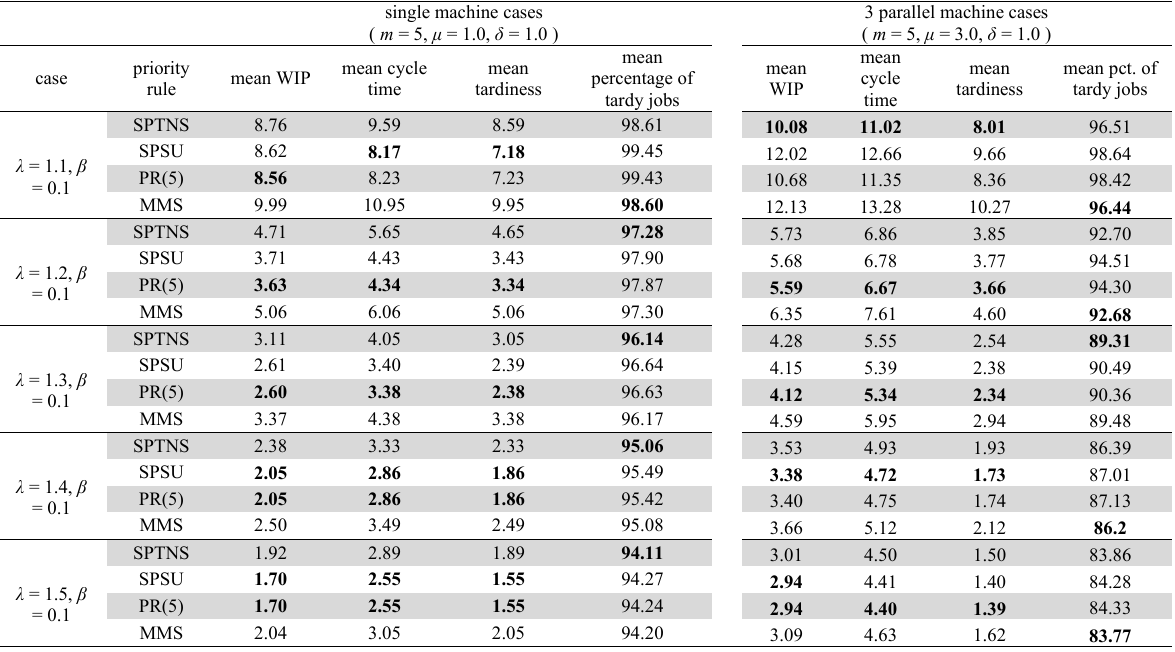
Comparison between SPSU, SPTNS, MMS and PR (continues in Table 11). The minimum values for each performance metric and simulation case are denoted in bold.